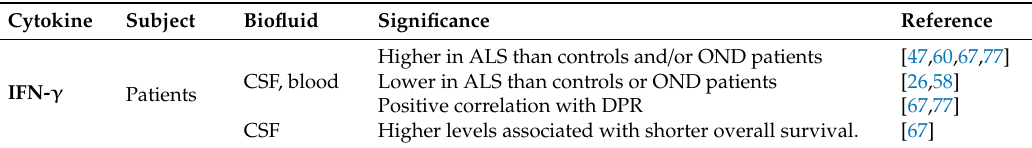
Table 3. Interferons (IFN) found dysregulated and proposed as biomarkers in biofluids from ALS patients.